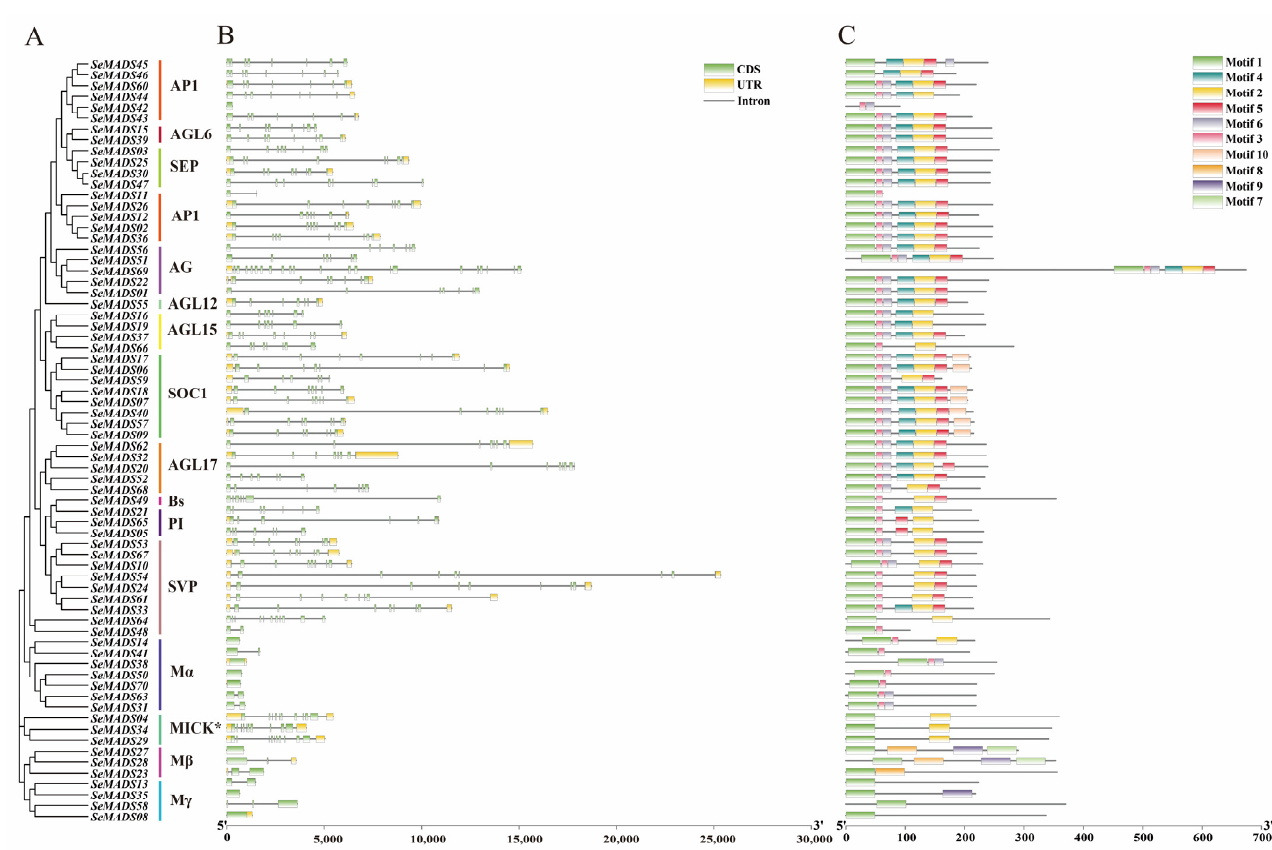
Figure 3. Protein conserved motif and gene structure analysis of SeMADS-box. ( A ) Neighbor-joining tree of SeMADS-box constructed by MEGA X. ( B ) Gene structure of SeMADS-box. ( C ) Protein conserved motif of SeMADS-box.